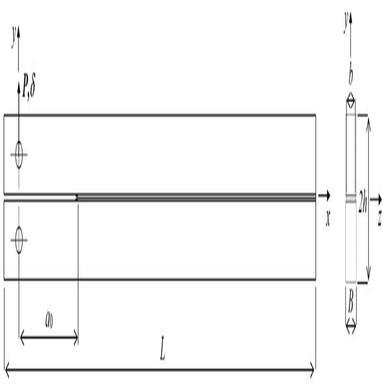
Geometric configuration of the DCB test specimen using loading holes.